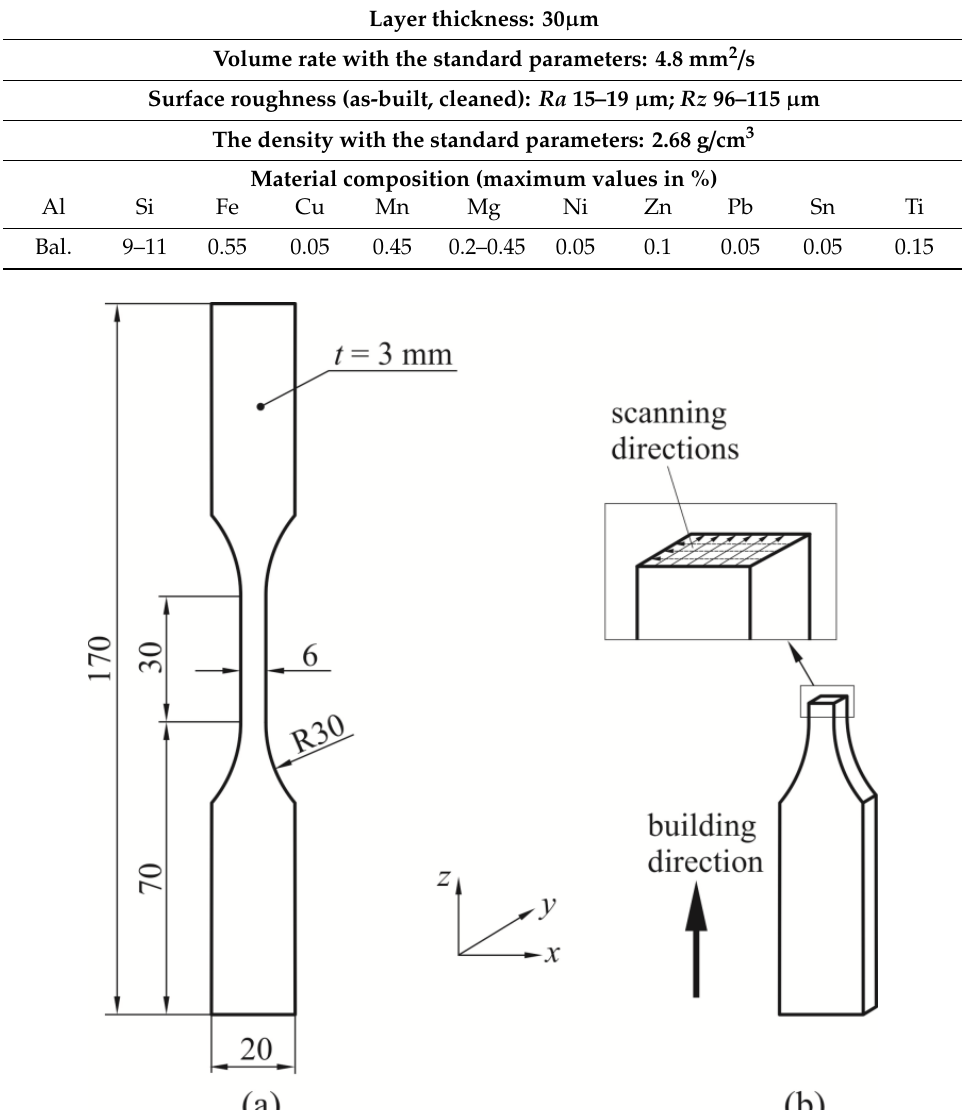
Table 1. Material data sheet of Selective Laser Melting (SLM) AlSi10Mg alloy.